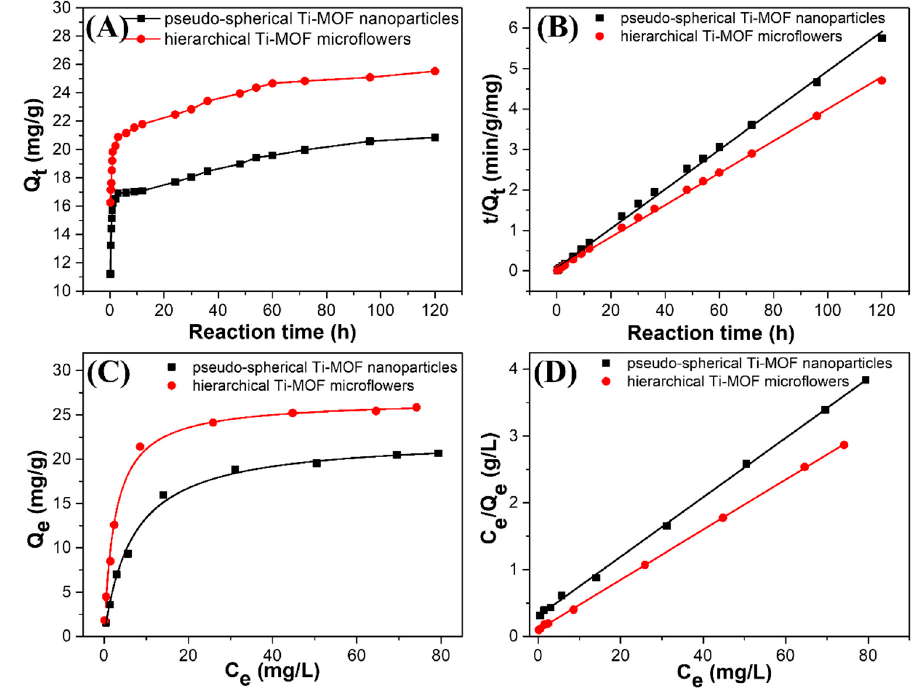
Figure 5. ( A ) Kinetics of Al(III) adsorption and ( B ) the corresponding fitting curves for pseudo-spherical Ti-MOF particles and hierarchical Ti-MOF microflowers via a pseudo-second-order kinetic model (50 mg·L − 1 of the initial concentration of Al(III), 1 g·L − 1 of adsorbents with initial solution pH 4.7 ± 0.1 at 25 °C). ( C ) Isothermal adsorption of Al(III), and ( D ) the corresponding plots of C e /Q e versus C e for pseudo-spherical Ti-MOF nanoparticles and hierarchical Ti-MOF microflowers (2–100 mg·L − 1 of initial Al(III) concentration, 1 g·L − 1 of adsorbents, 96 h of equilibrium time at 25 °C and initial pH 4.7 ± 0.1). Table 1. Adsorption parameters of Al(III) on both type of Ti-MOF.